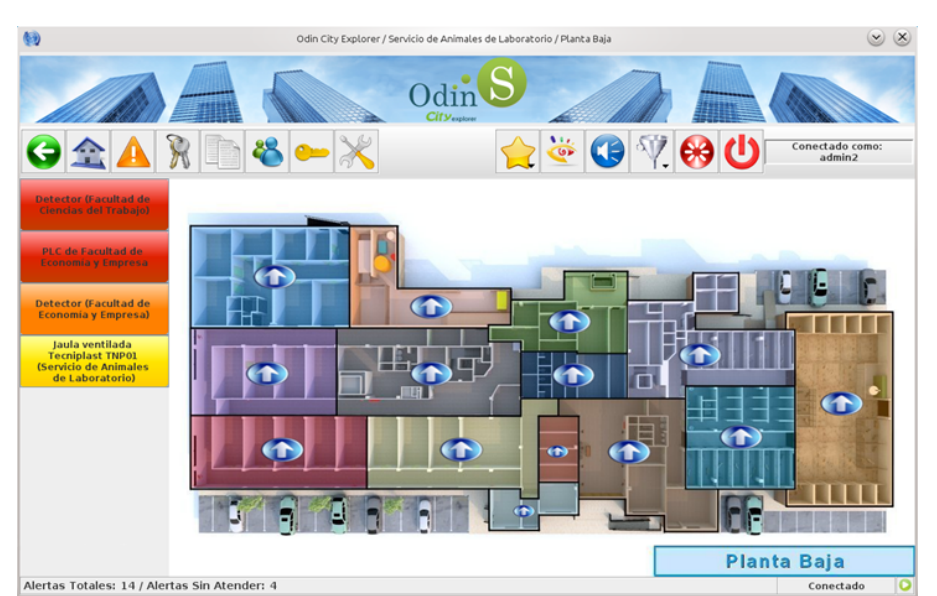
Figure 11. Use case 1: Smart campus